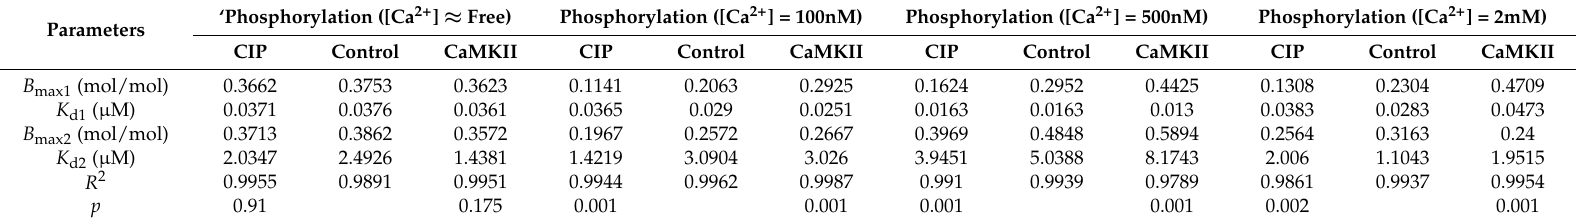
Table 3. Parameters for the bindings of CaM to phosphorylated Na V 1.1 IQ